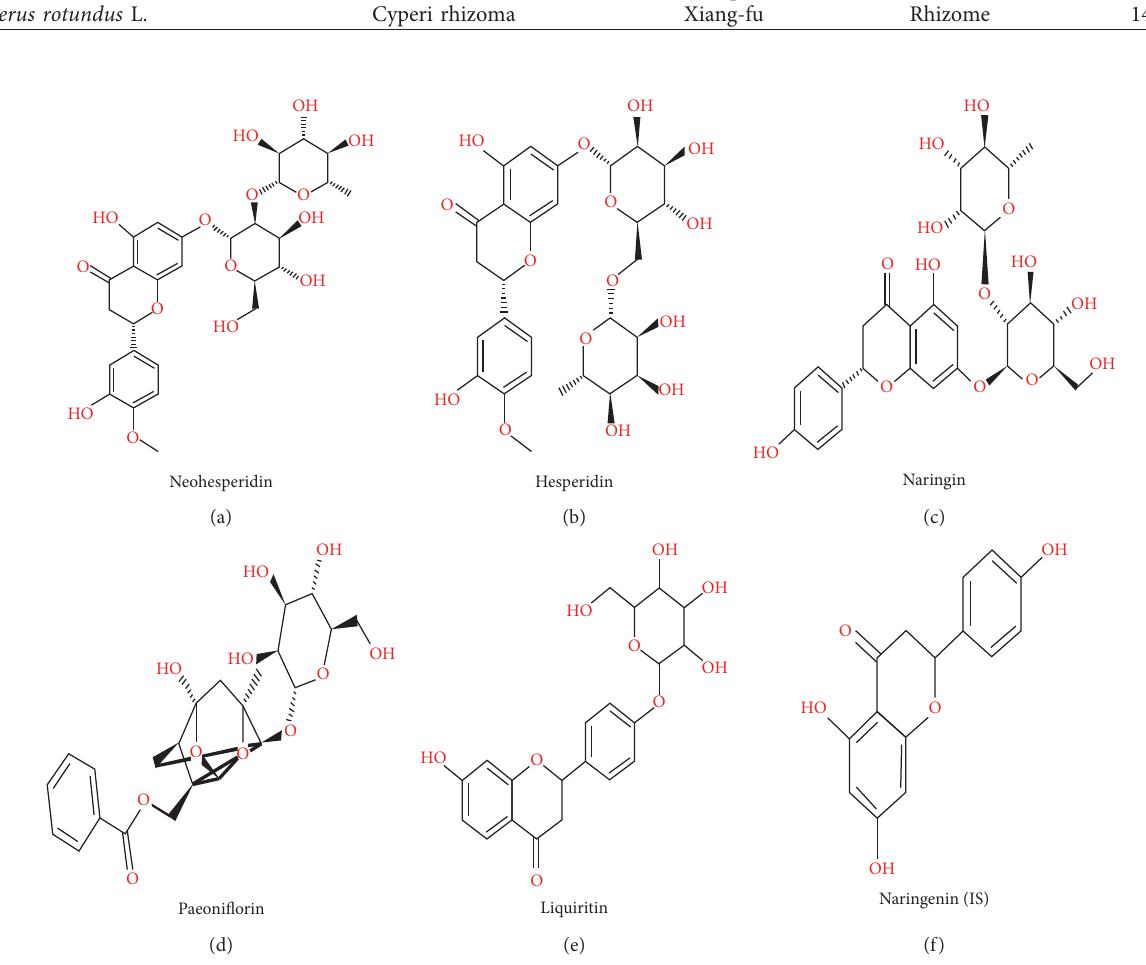
Figure 1: The structure of all analytes and IS. Table 2: The specific information of all analytes and